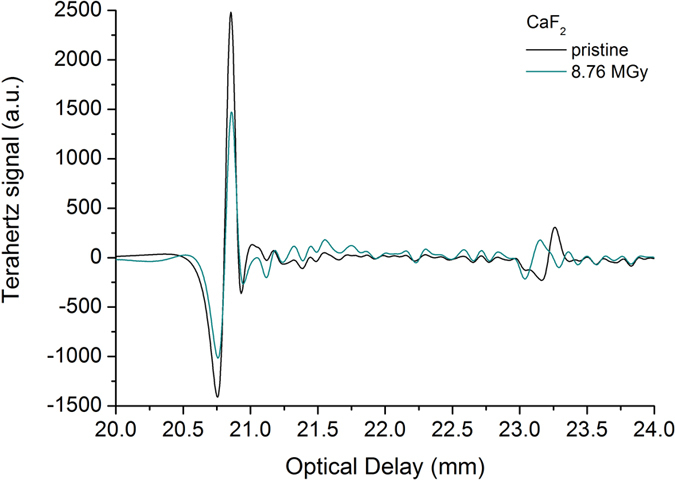
Delay of the transmitted THz pulse as induced by alpha particle irradiation for the case of CaF2.